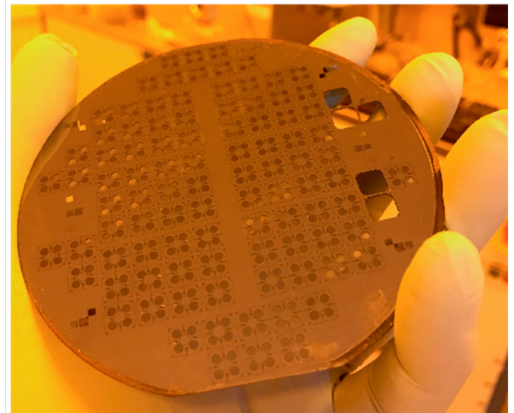
Figure 6. Fabricated devices on a 4” SOI wafer.